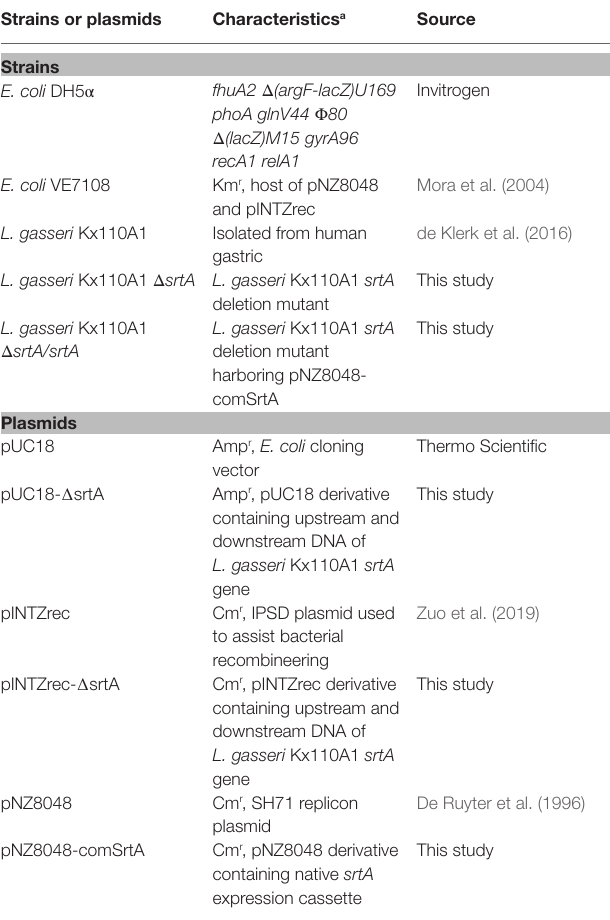
TABLE 1 | Bacterial strains and plasmids used in this